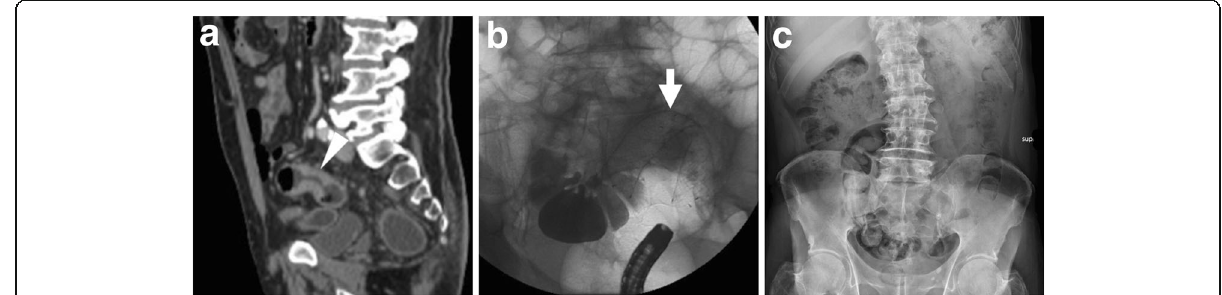
Fig. 17 Spontaneous stent migration. In a patient with endoscopically impassable sigmoid CRC (arrowhead in initial water enema CT, a ) with liver metastases (not shown) at diagnosis, multidisciplinary consultation opted to postpone surgical resection after neoadjuvant chemotherapy. A SEMS (thick arrow) was positioned endoscopically under radiologic guidance ( b ) and allowed relief of LBO, clinical improvement and start of chemotherapy. A month later, the patient experienced evacuation of the SEMS with stools and radiographs ( c ) confirmed SEMS loss [adapted from Open Access Ref.